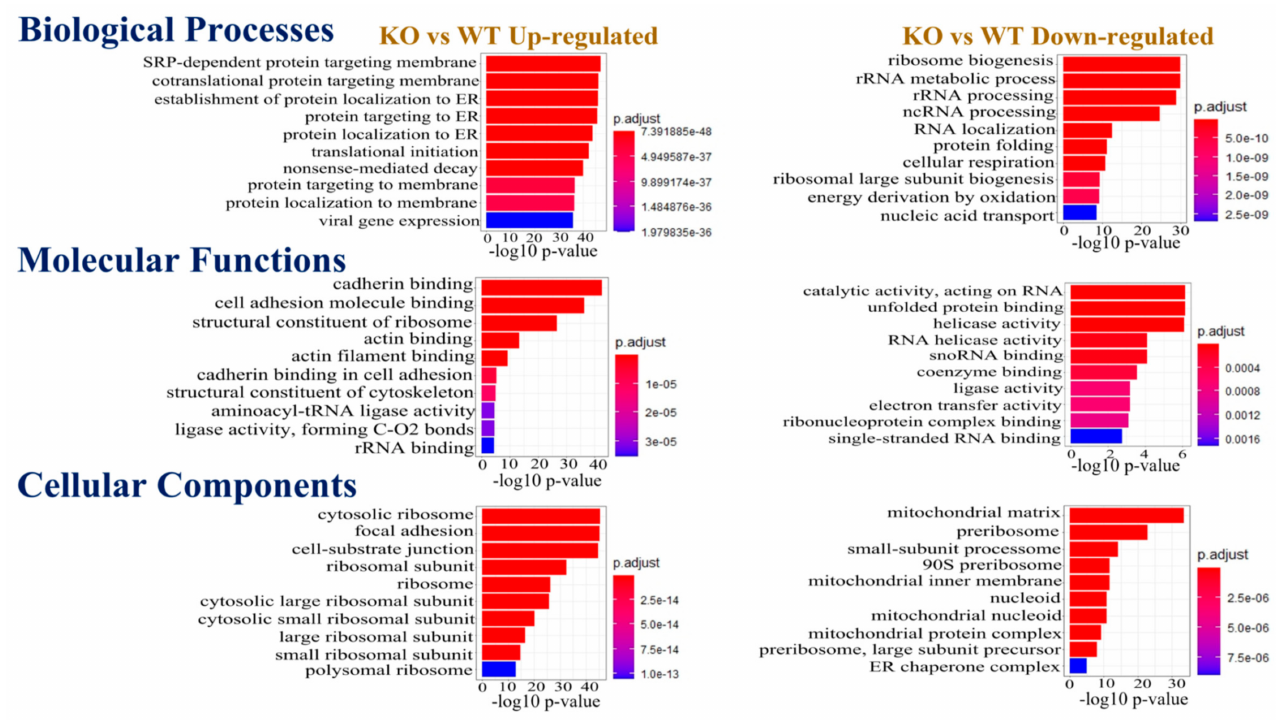
Figure 2. Functional enrichment analysis of differentially expressed proteins between WT and KO MDA-MB-231 cells. Gene Ontology Consortium for the Biological Processes, Molecular Functions, and Cellular Components, respectively, were used in this analysis. Data show the top 10